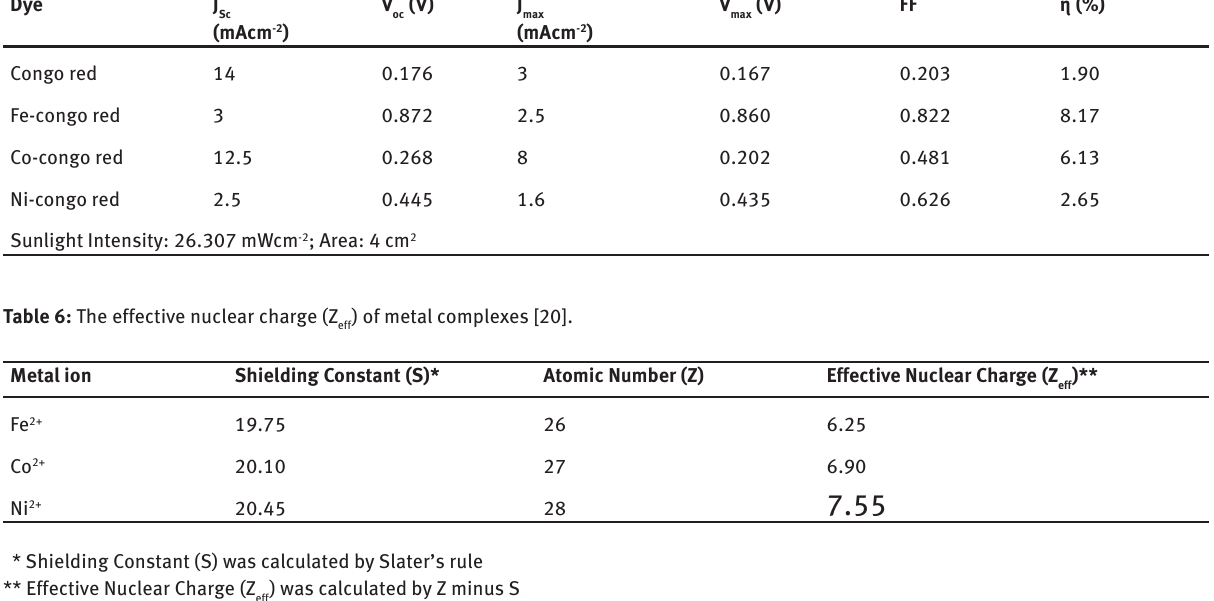
Table 5: The photovoltaic performance of congo red complexes. Dye